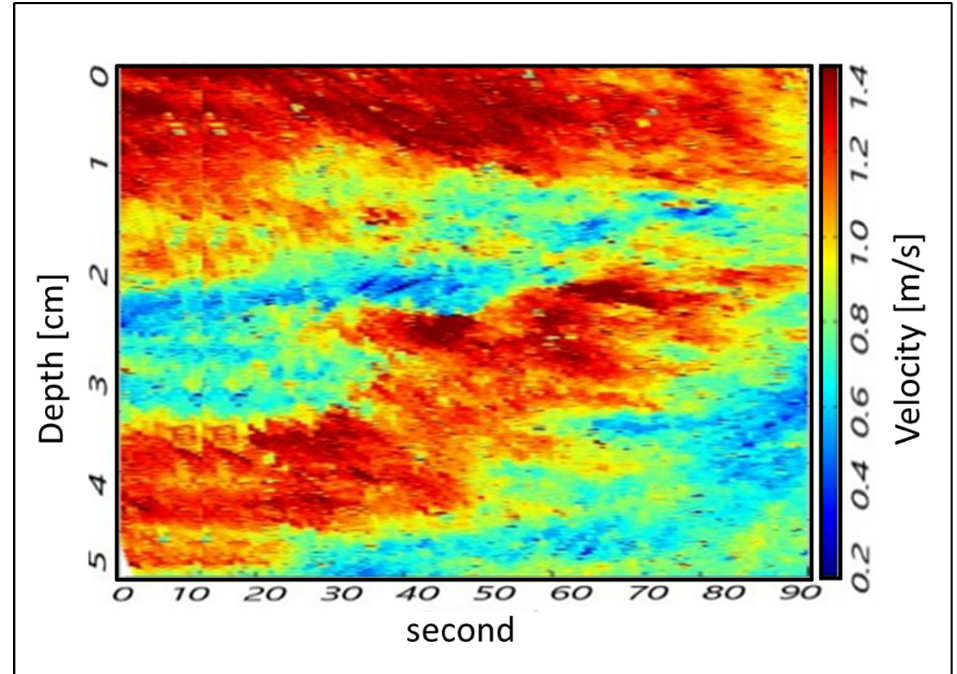
Figure 16. Detection of water velocity as a function of the temperature using Doppler processing: cold water—bottom; hot water—surface, for cross-section A.